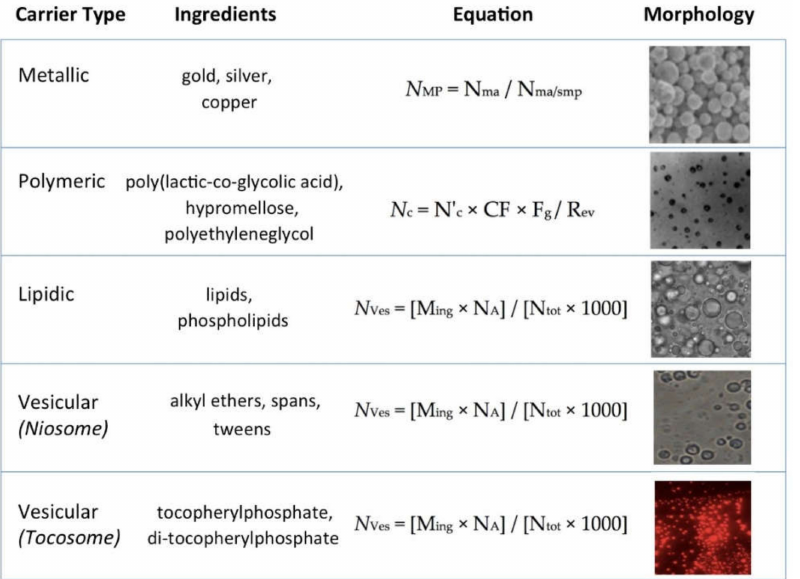
Figure 3. Simple equations for the quantification of particle number of major groups of bioactive carrier systems, generally used ingredients for their manufacture and microscopic image of each class of carrier